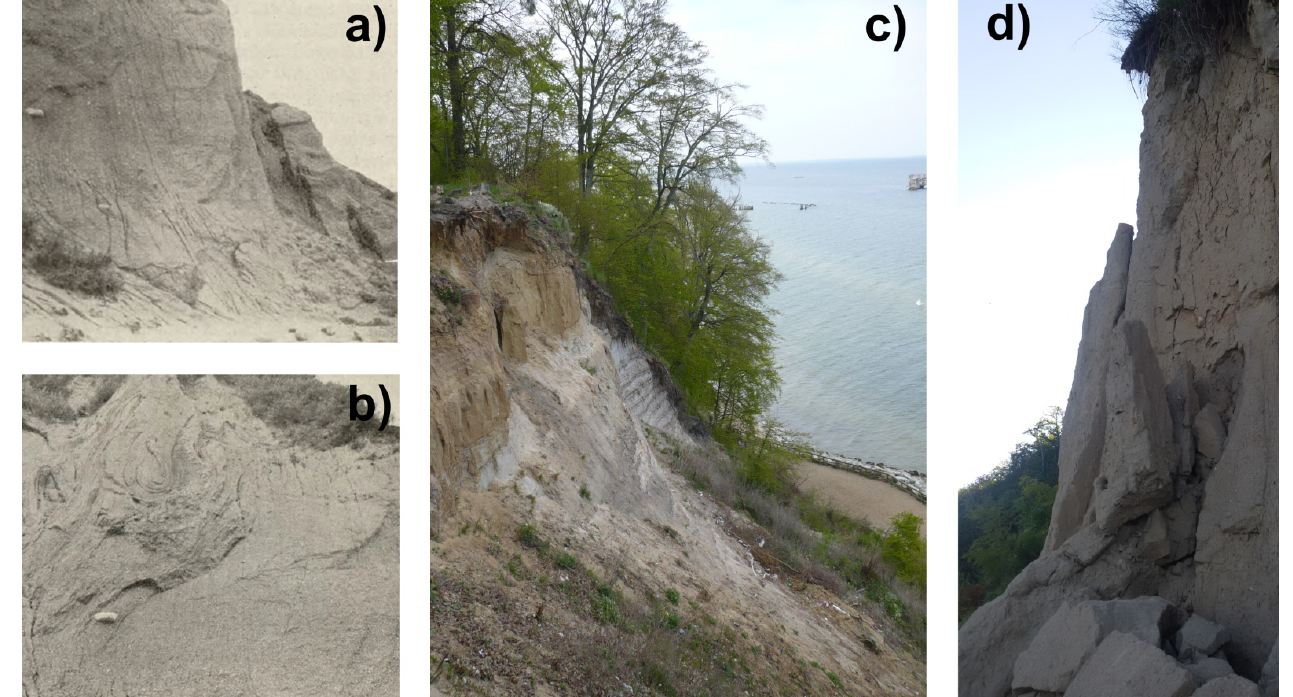
Figure 2. ( a ) Earth fall developed in glacial till at Oksywie Cliff (Sonntag, 1910) [45]; ( b ) earth slide at Oksywie Cliff, escarpment carved in Pleistocene glacitectonic sands and silts (Sonntag, 1910) [45]; Cliff, escarpment carved in Pleistocene glacitectonic sands and silts [45]; ( c ) earth slide in Babie ( c ) earth slide in Babie Do ł y, Gdynia, escarpment carved in Pleistocene glacial till and Neogene Doły, Gdynia, escarpment carved in Pleistocene glacial till and Neogene glaciotectonic rafts inside glaciotectonic rafts inside glacial till, May 2012 (photo: Ma ł ka); ( d ) earth fall developed in glacial till at Red ł owo Cliff, August 2016 (photo: Ma ł ka). glacial till, May 2012 (photo: Małka); ( d ) earth fall developed in glacial till at Redłowo Cliff, August 2016 (photo: